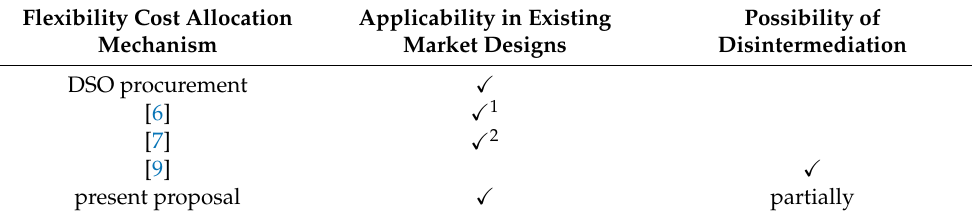
Table 1. Most important properties of flexibility cost allocation